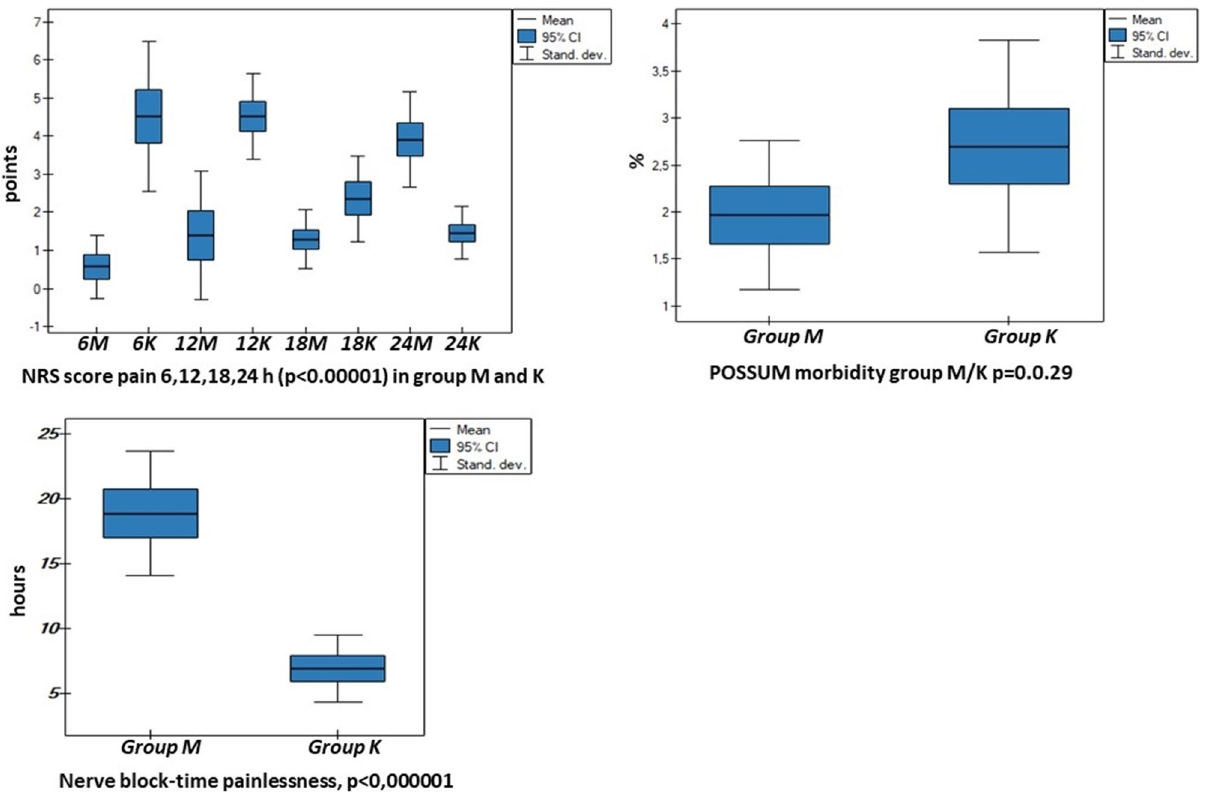
Figure 2. Correlation parameters between group M and K: NRS score pain 6, 12, 18 h (p < 0.00001), POSSUM morbidity (p = 0.029), nerve block—time painlessness (p < 0.000001).